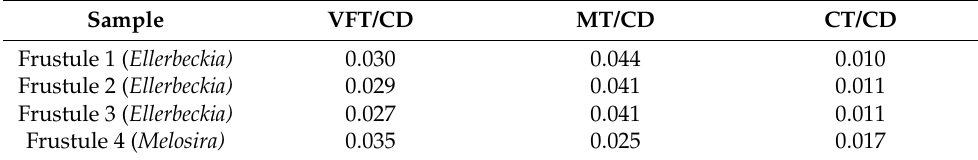
Figure 7. Diagrams of the studied fossil frustules. ( a ) Schematic diagram of studied fossil frustules with two diatom cells (light green and blue cylinders). Indicated are the valve mantle thickness (MT), valve face thickness (VFT), copulae thickness (CT) and cylindrical diameter (CD). Red arrows: positions of crack initiation. ( b ) Graph of the tendency of the maximum loading force on the cylindrical diameter. Blue points: Ellerbeckia , cyan point: Melosira . Table 2. Comparison of the different structure parameters with the cylindrical diameter.